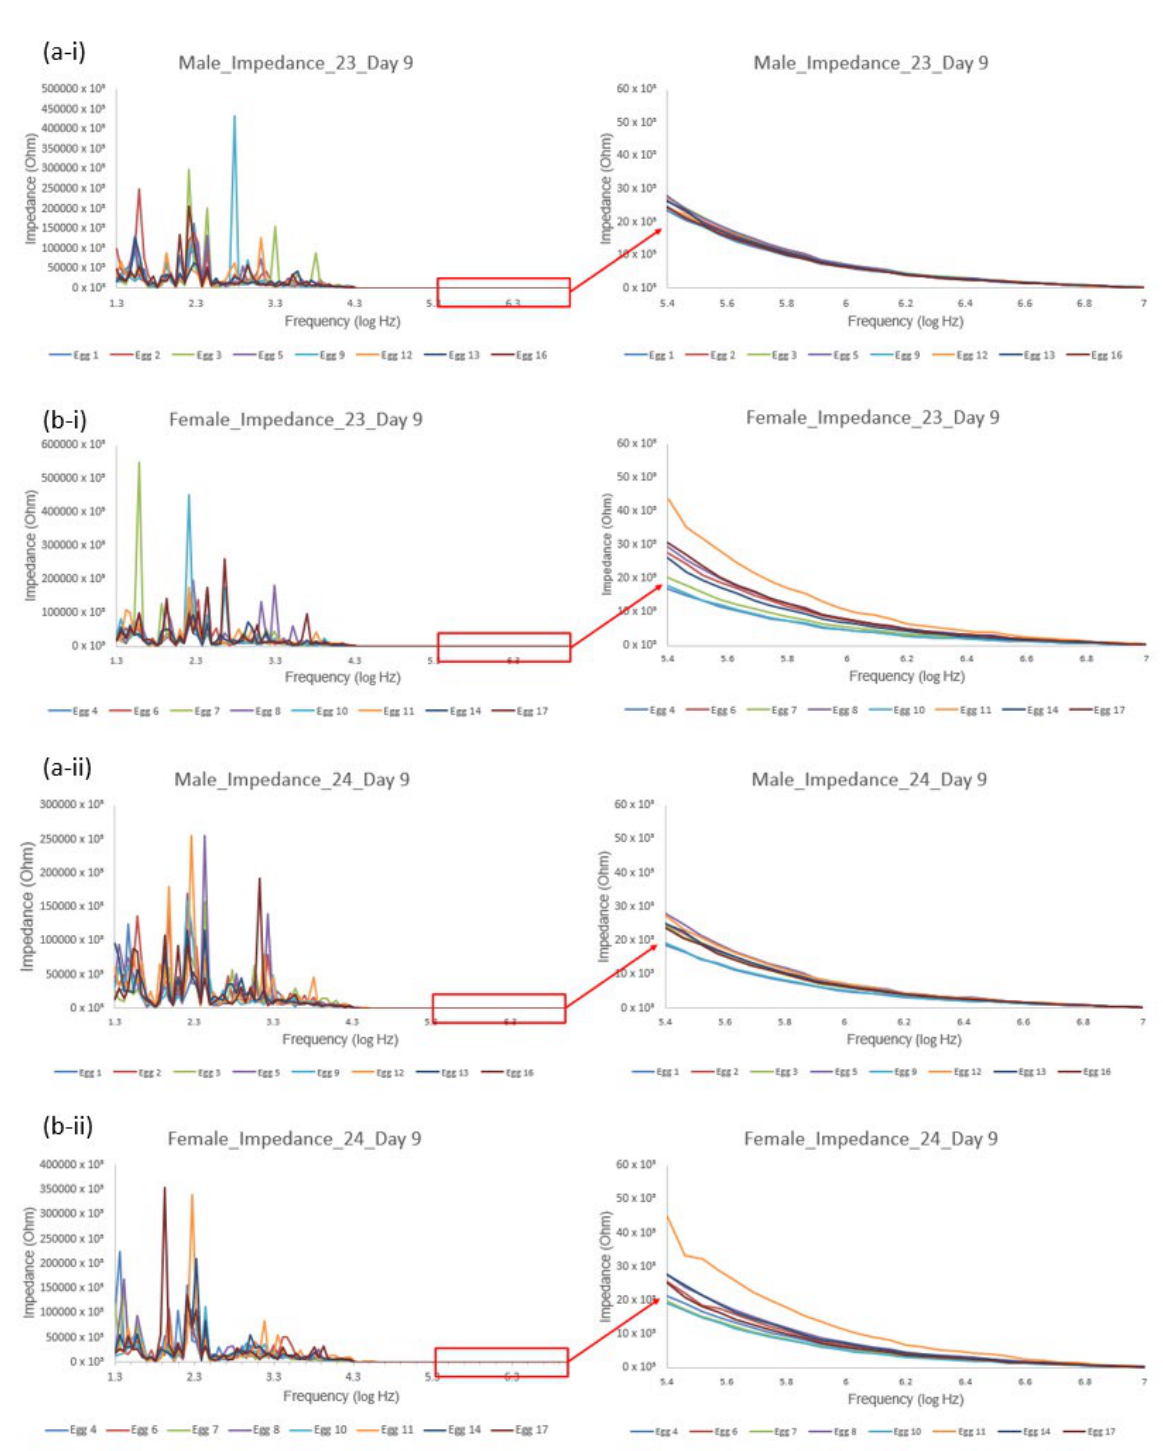
Figure 6. Impedance spectrum measurement of male ( a ) and female ( b ) eggs between electrodes at position 2–3 ( i ) and 2–4 ( ii ) on Day